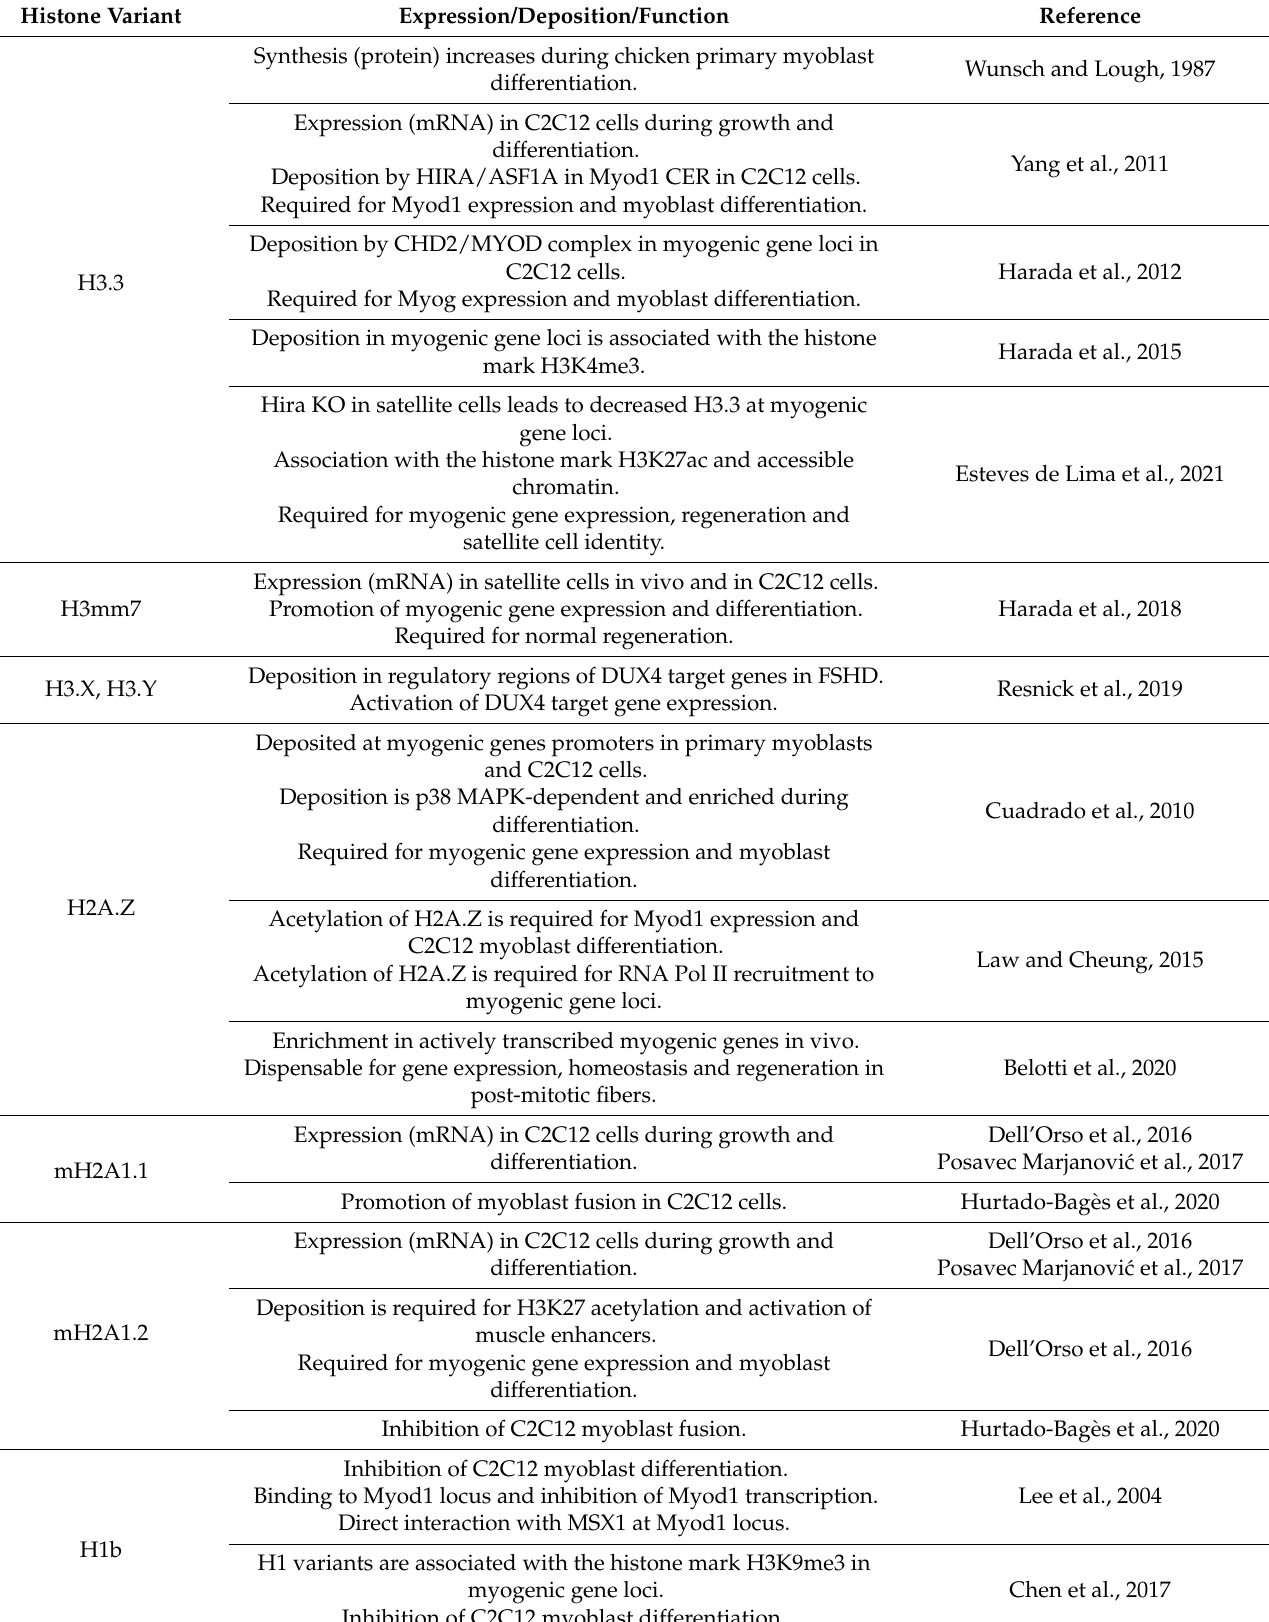
Table 1. List of the histone variants that regulate